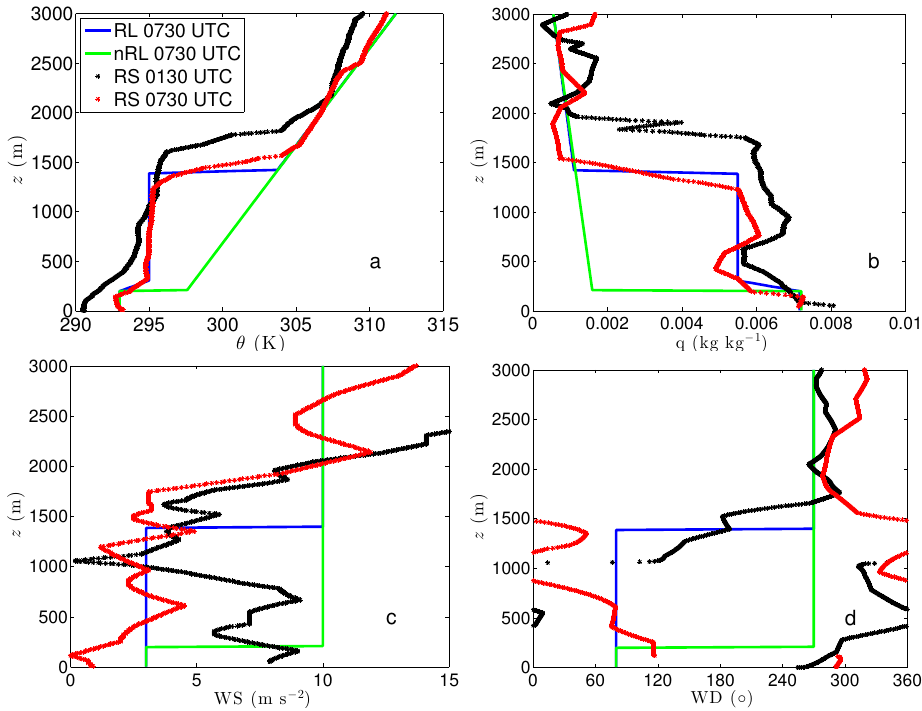
Fig. 2. Vertical profile of (a) potential temperature, (b) specific humidity, (c) wind speed and (d) wind direction observed by the radio soundings launched at 01:30 (black dots) and at 07:30 UTC (red dots) on 1 July 2011. Additionally, the vertical profiles based in the observations for initializing the DALES RL numerical experiments (solid blue) and nRL numerical experiments (solid green) are shown. Table 1 shows the values which characterize initial profile of θ , q , u and v .